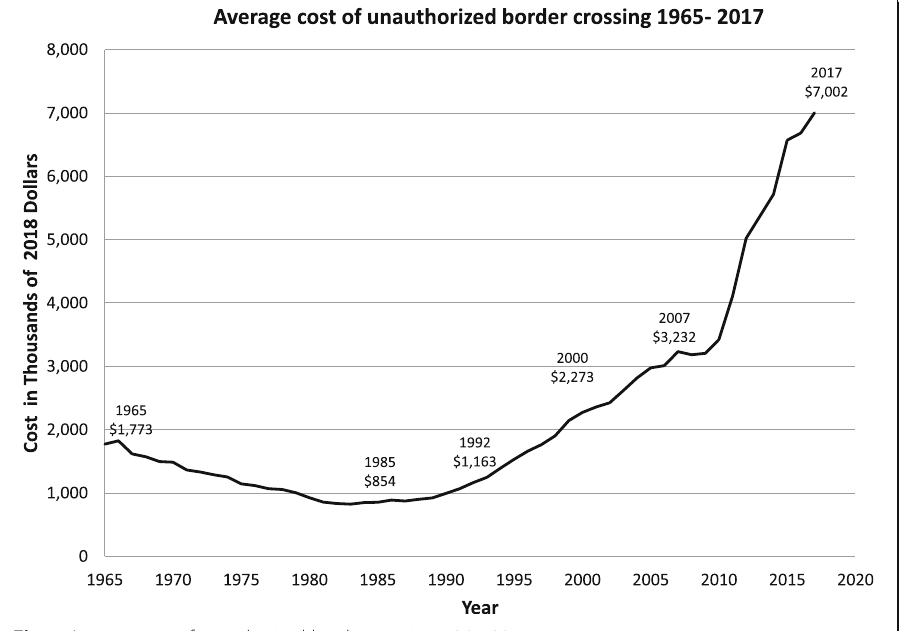
Fig. 7 Average cost of unauthorized border crossing 1965 –